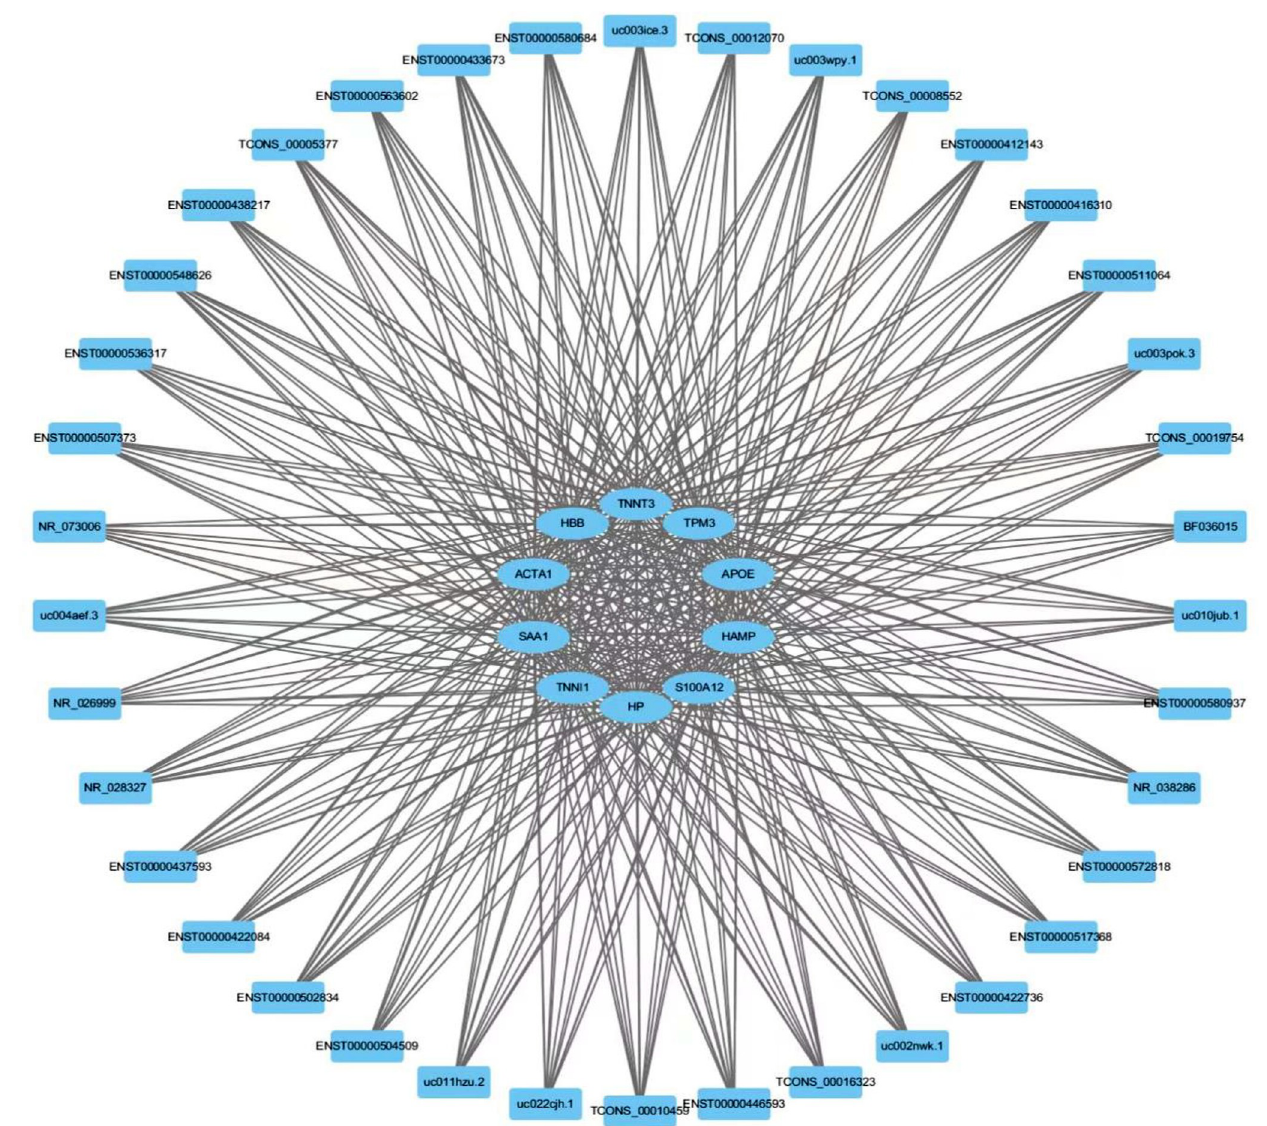
Fig 5. Construction of lncRNA-mRNA network. ellipse nodes, hub mRNAs; rectangle nodes, lncRNAs.